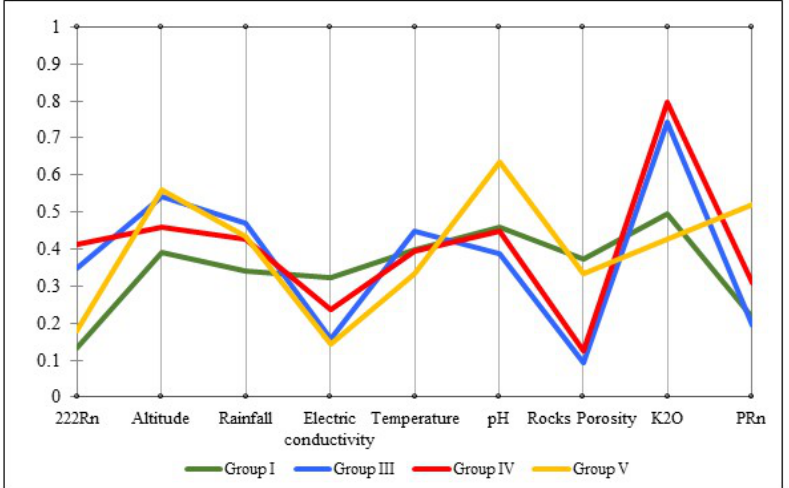
Figure 4. The distribution of dissimilarities results through parallel coordinate visualization plots (PCV).